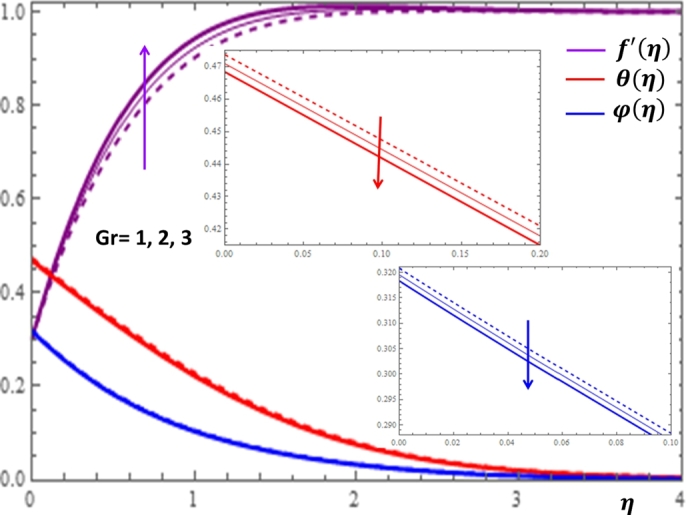
Impacts of thermal buoyancy parameter Gr on f′(η), θ(η) and φ(η).